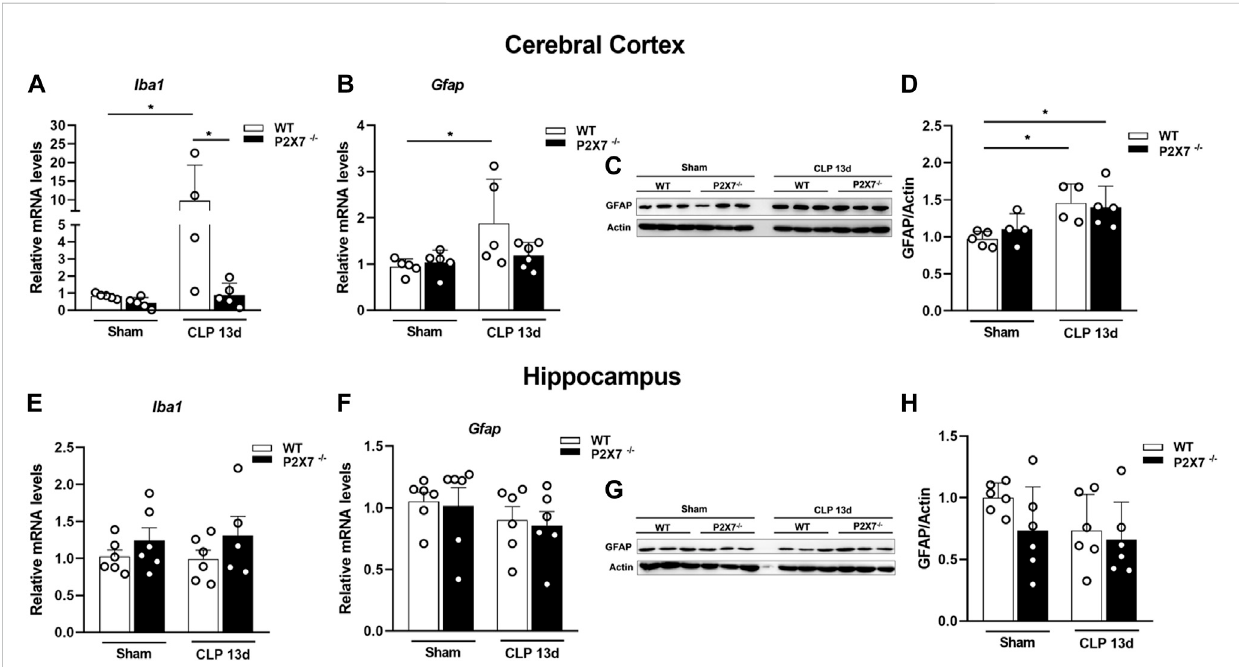
FIGURE 3 Genetic deletion of P2X7 receptor decreases glial markers Iba-1 and GFAP gene expression in mice cerebral cortex 13 days after surgery. Gene expressionIba-1andGFAPwereanalyzedbyRT-qPCRandGFAPproteinlevelswereanalyzedbyWesternblotting13 daysaftersepsisinduction.Iba-1 (A) and GFAP (B) expression in the cerebral cortex and hippocampus (E, F) . Representative Western blot membranes (C, G) with densitometric analysis of GFAP (D, H) . Data are expressed as mean ± SEM; One-way ANOVA followed by Tukey ’ s post hoc. Statistical differences between groups are represented by asterisks (* p < 0.05). Symbols represent individual mice. ( n = 4 –